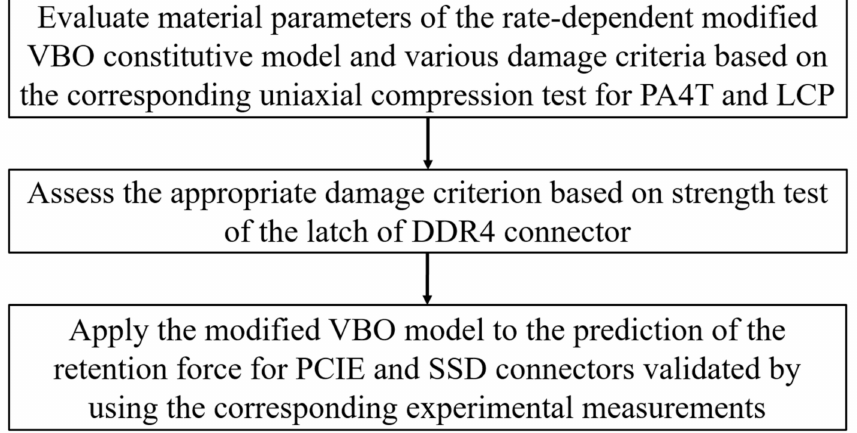
Figure 5. A flowchart of the logical relationships among three experiments.